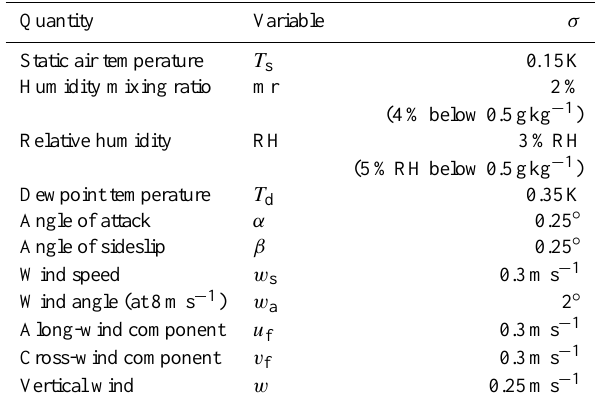
Table 5. List of the calculated measurement uncertainties of the main derived parameters. Details to the method and the calculation of the presented results are given in the